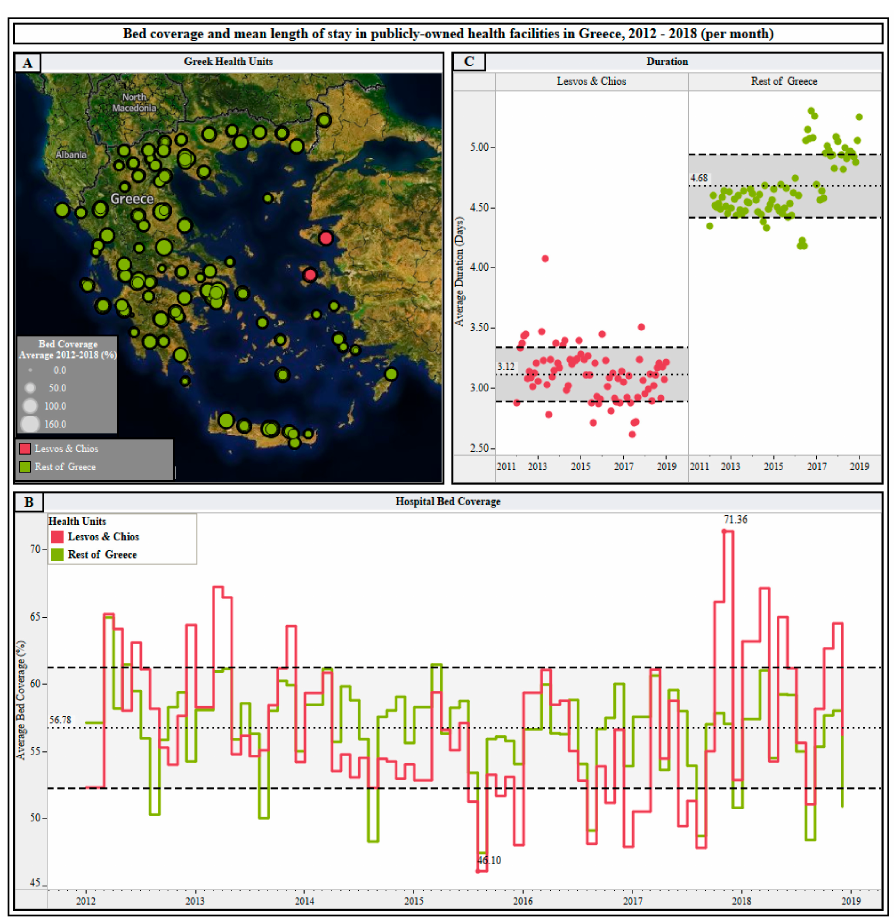
Figure 1. A visual comparison of bed coverage and length of hospital stay between publicly-owned health facilities in main reception centers on the Aegean islands of Lesvos and Chios and the rest of Greece, 2012–2018. ( A ): The red circles represent bed coverage in the main reception centers on Lesvos and Chios per publicly-owned hospital, 2012–2018; the green circles represent bed coverage in publicly-owned health facilities on the mainland. The area of the circle depicts the mean percentage of bed coverage per publicly-owned hospital in Greece, 2012–2018; ( B ): Variance of the mean bed occupancy rate in publicly-owned health facilities in the main reception centers on Lesvos and Chios (red line) and publicly-owned health facilities on the mainland (green line) per month for the period 2012–2018. The mean overall bed occupancy rate for the period 2012–2018 was 56.78 ± 4.48% in Greece. The mean bed occupancy rate in Lesvos and Chios has been greater than the overall Greek mean bed occupancy rate since the end of 2017; ( C ): Red points represent the mean length of hospital stay (days) in publicly-owned health facilities in main reception centers on Lesvos and Chios per month for the period 2012–2018 (mean length of stay over the entire period: 3.12 ± 0.23 days). Green points represent the mean length of hospital stay (days) in publicly-owned health facilities in the rest of Greece per month for the period 2012–2018 (mean length of stay over the entire period: 4.68 ± 0.26